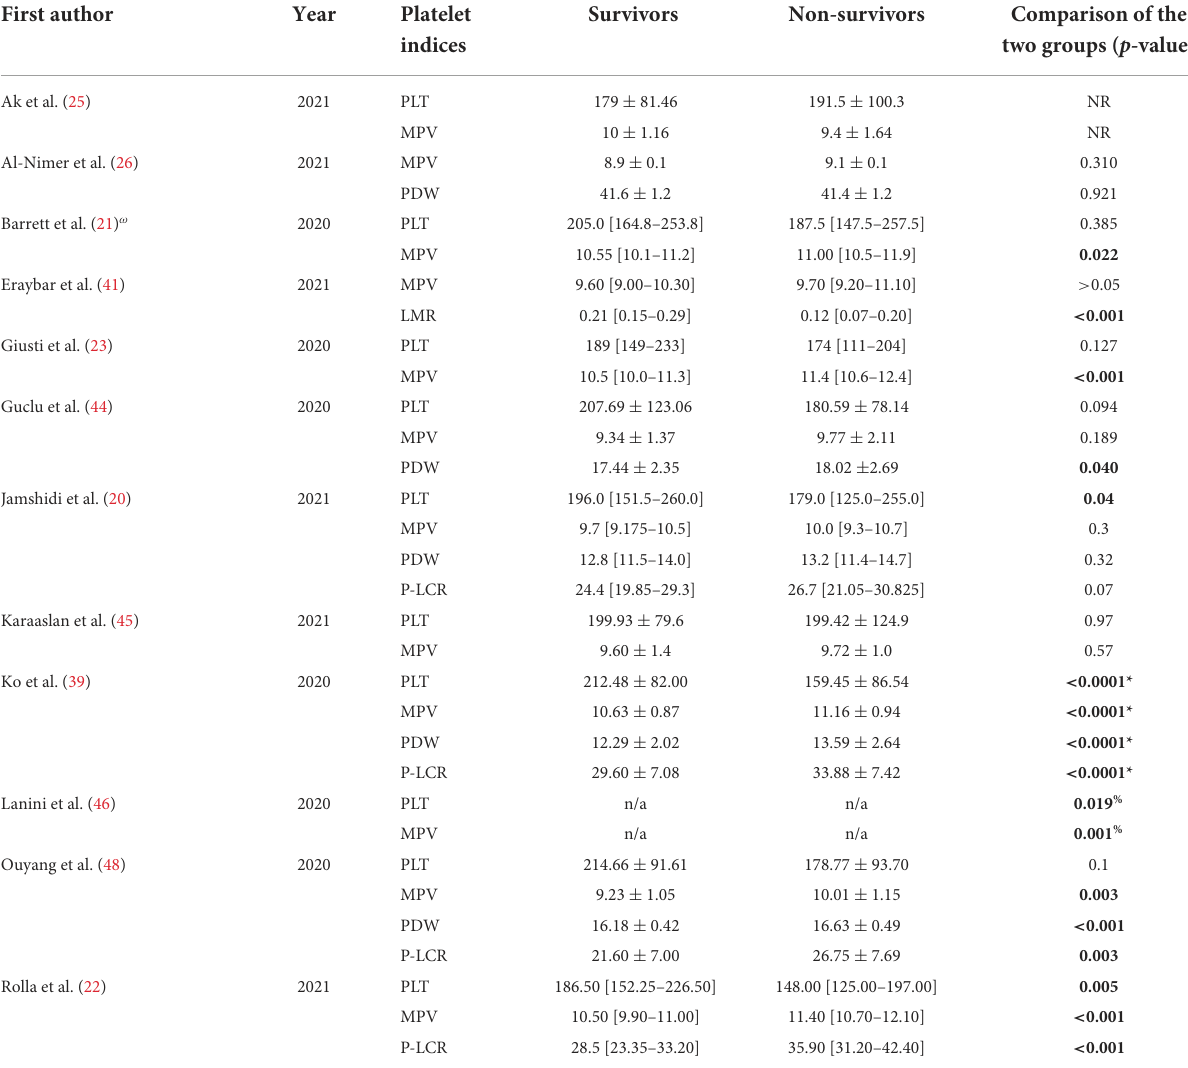
TABLE 3 Values of platelet indices in the COVID-19 patient survivor and non-survivor groups at